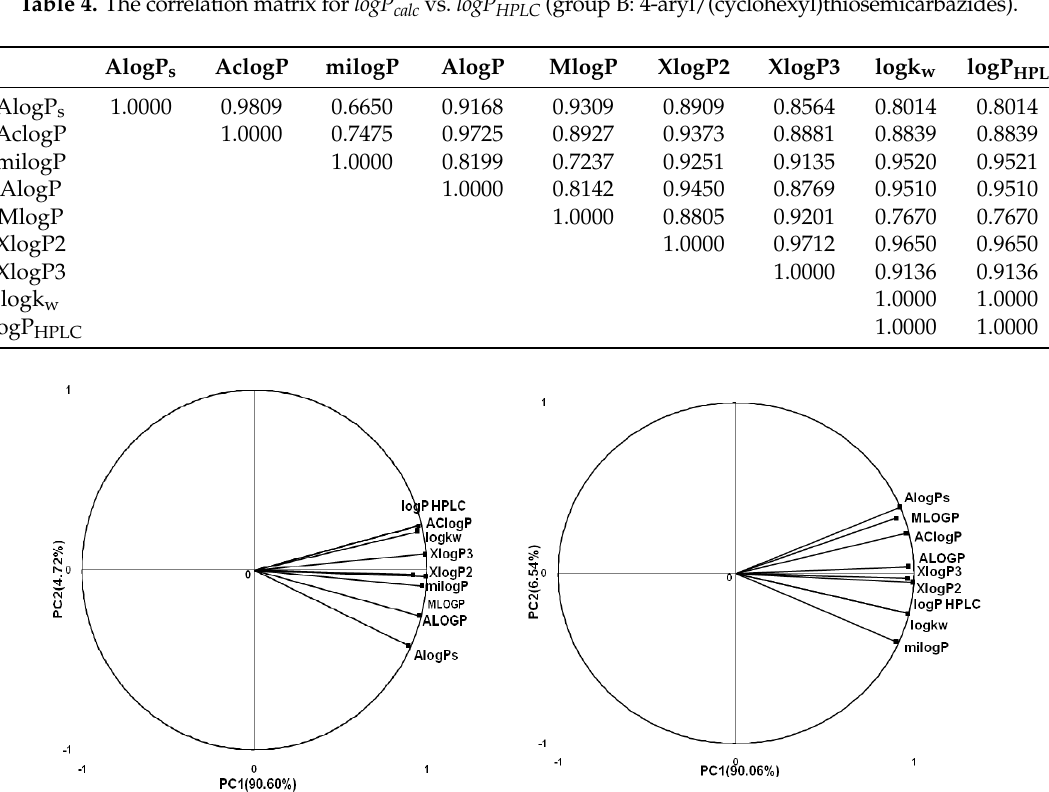
Figure 1. The PCA graphs for calculated and experimental lipophilicity parameters of 4-benzoylthiosemicarbazides (group A) and 4-aryl/(cyclohexyl)thiosemicarbazides (group